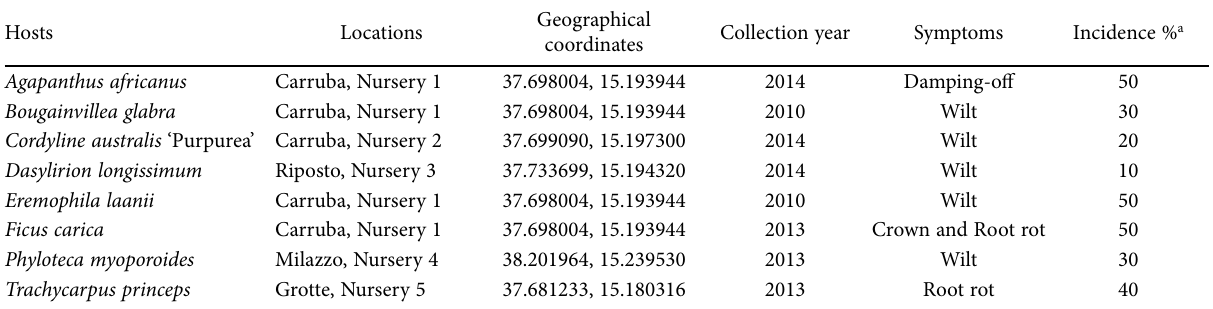
Table 1. Hosts, locations, symptoms and incidence (%) of diseases caused by Fusarium and Neocosmospora in Sicily (Southern Italy).